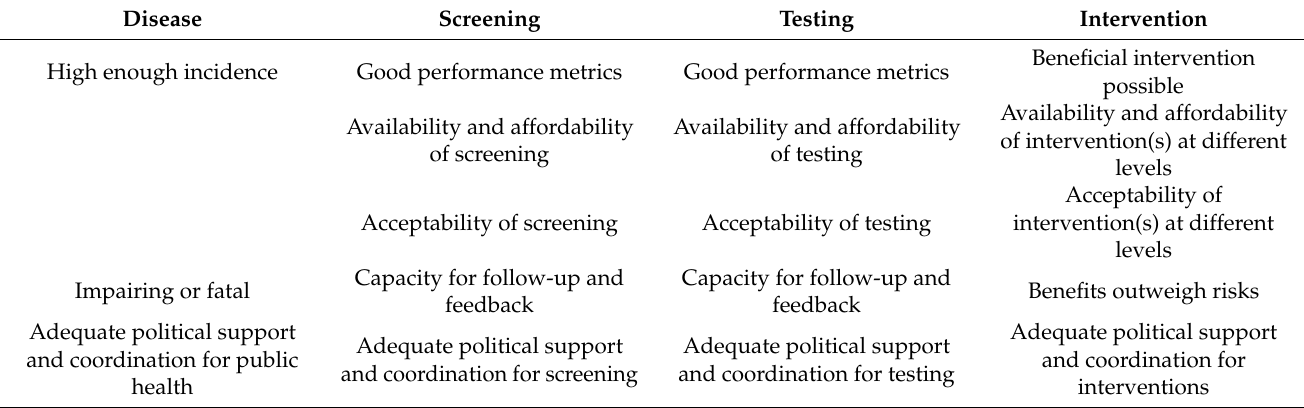
Table 2. Criteria for effective screening and testing